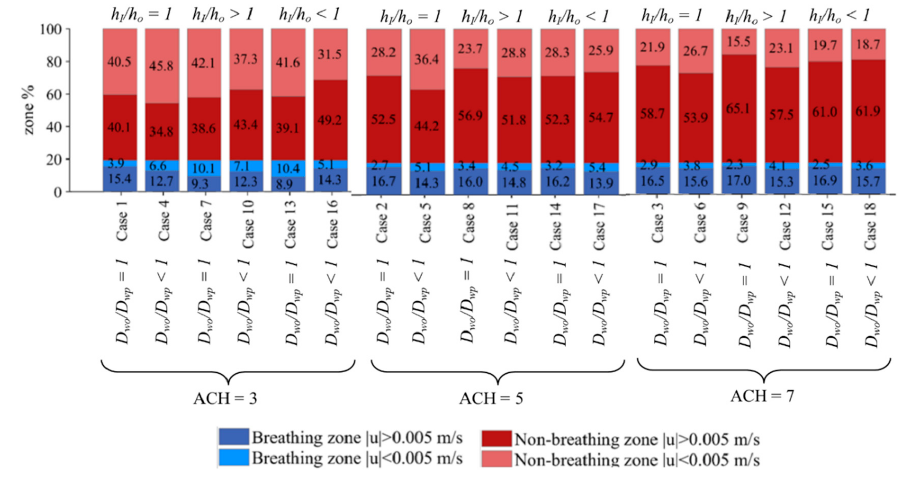
Figure 2. Velocity contour plots at air changes per hour (ACH) = 5 for ( a ) case 2, ( b ) case 5, ( c ) case 8, and ( d ) case 11; velocity contour plot at ACH = 3 for ( e ) case 16, and at ACH = 7 for ( f ) case 18.